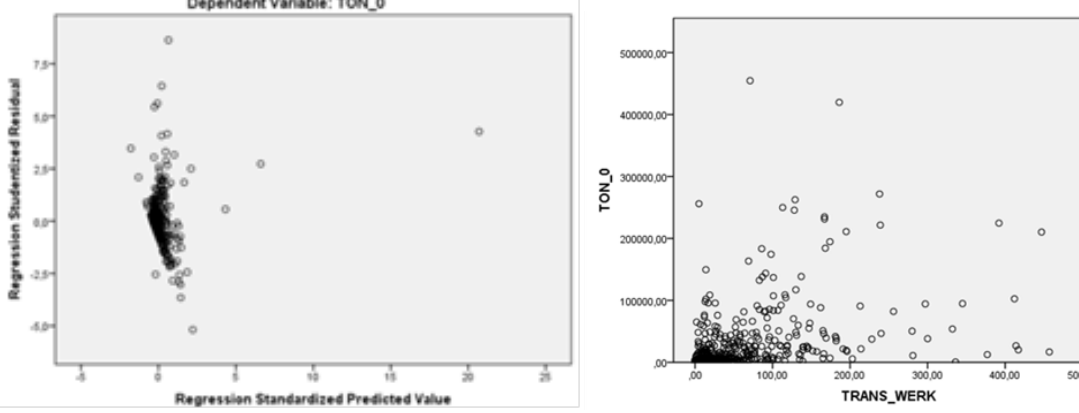
Figure 2. Scatterplots used to check the assumptions on homoscedasticity (left) and linearity (right).